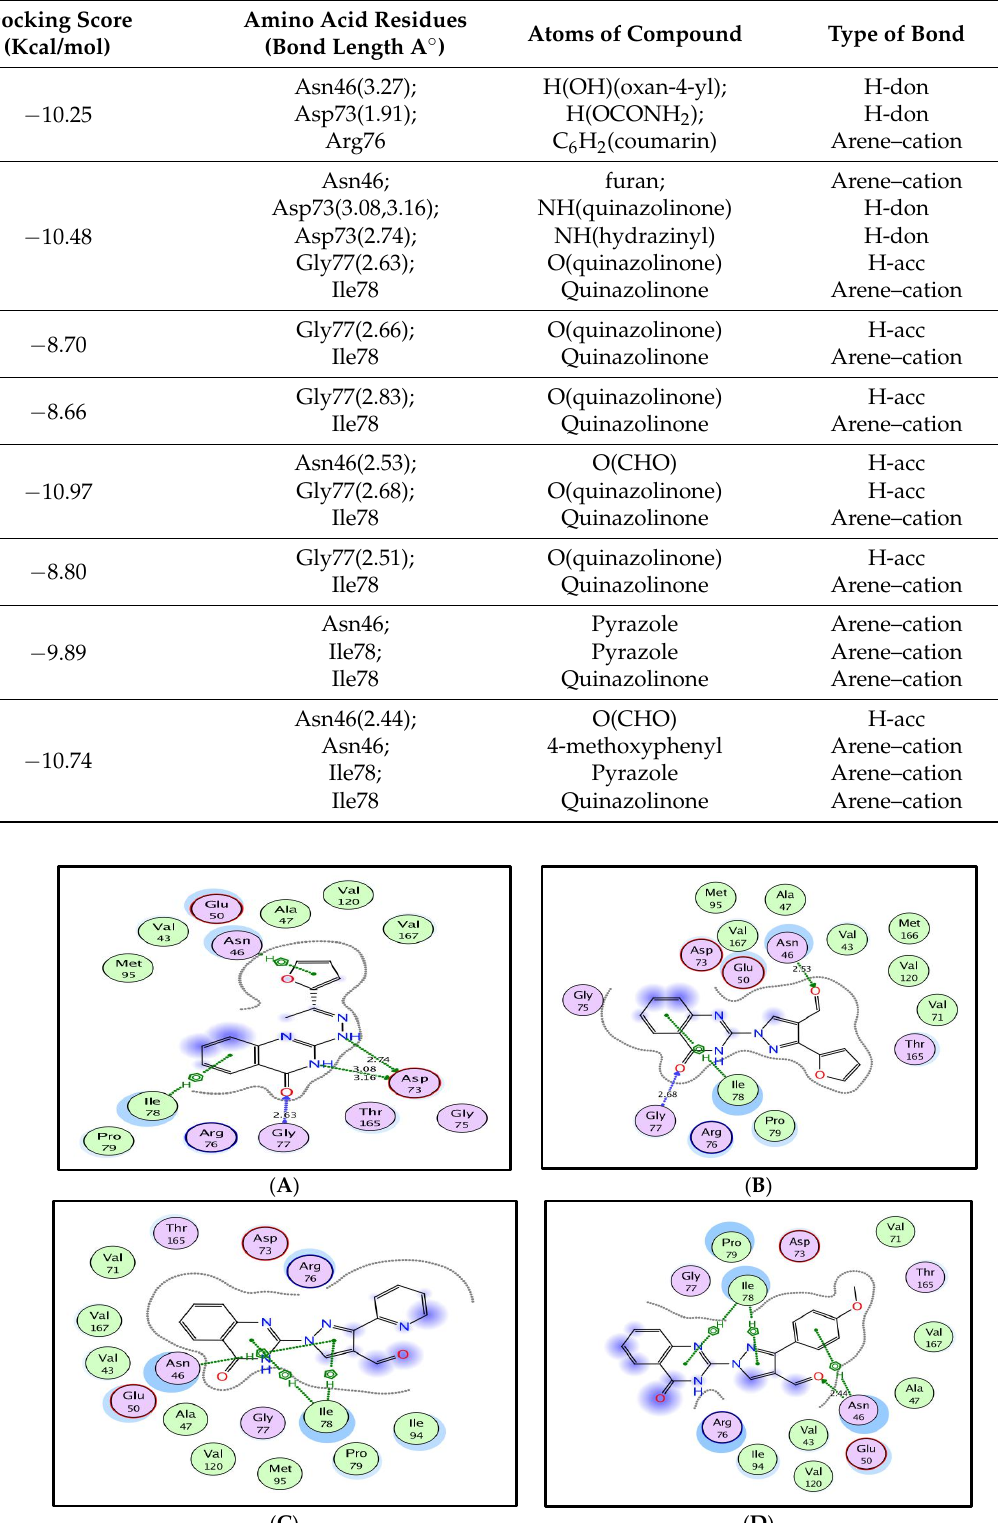
Figure 4. ( A – D ) Maps illustrate the 2D-binding poses of the promising quinazolinone targets, 4a , 5a , 5c , and 5d within the active site of E. coli DNA gyrase B (PDB code: 1AJ6).